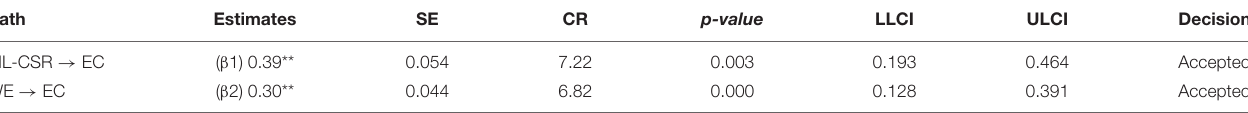
TABLE 4 | Results for hypotheses testing (H1 and H2).